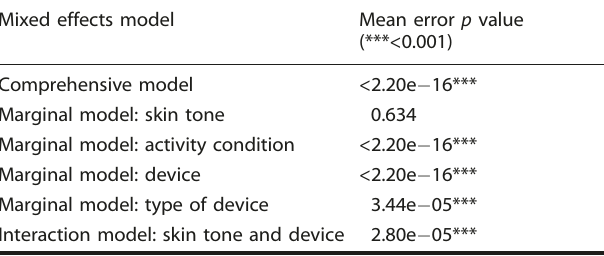
Fig. 1 Graphical abstract of research. Graphical abstract of research study presented. We present a full characterization of HR accuracy across skin tones, clinical metrics of HRV accuracy across skin tones, and HR during activity, rest, deep breathing, and typing for six wearable devices representing both consumer wearables and research-grade wearables. HR metrics are compared to the clinical-grade electrocardiogram (ECG) as the standard for heart rate measurement. Table 2. Results of mixed effects comprehensive and marginal